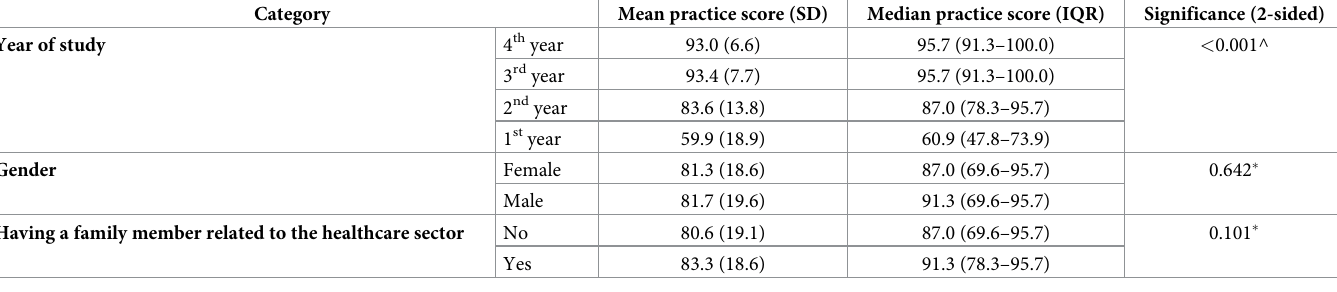
Table 4. Distribution of knowledge score according to the year of study, gender and having a family member related to the healthcare sector. Category